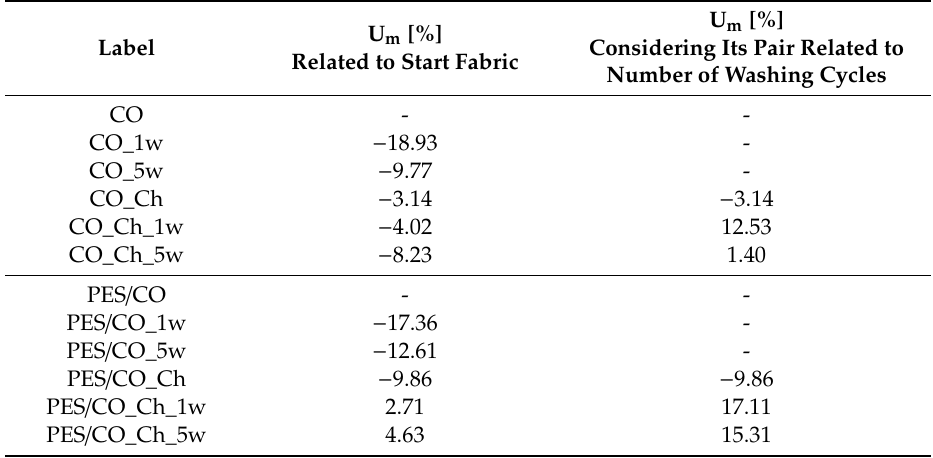
Table 3. Mechanical damage (U m [%]) of cotton (CO) and polyester / cotton blend (PES / CO) fabrics calculated related to start fabric and to its pair related to number of washing